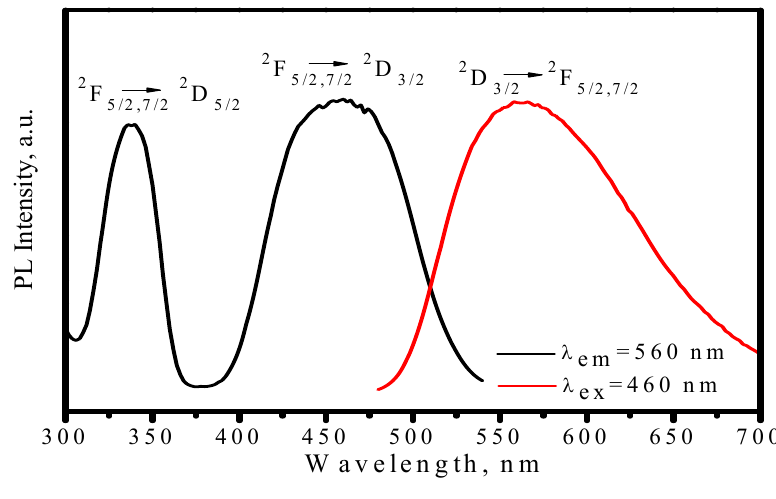
Figure 3. Excitation ( λ = 560 nm) and emission ( λ em Ce )Al O phosphor. (Y 2.93 0.07 5 12